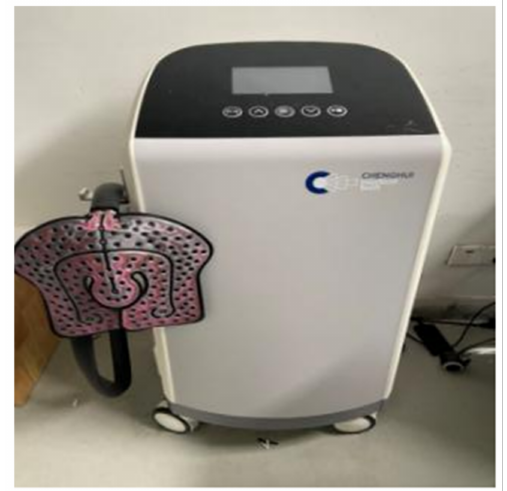
Figure 1. The peak power and peak force tests.